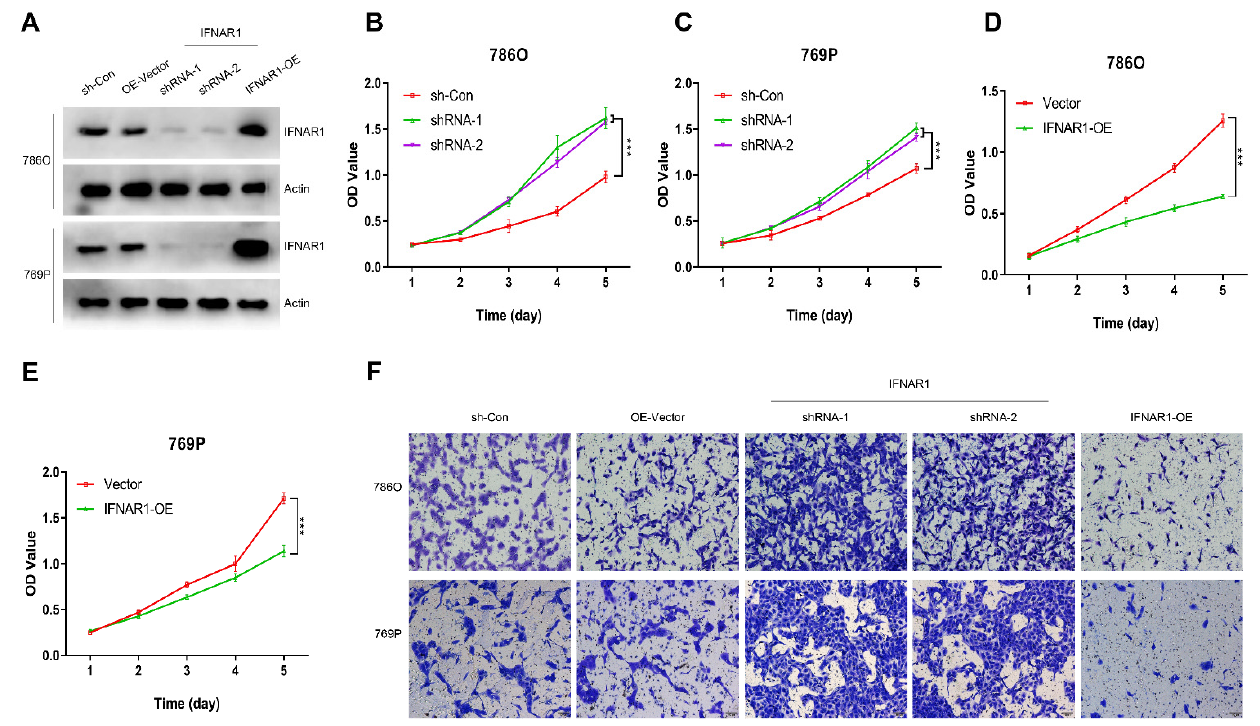
Figure 8. IFNAR1 inhibits the proliferation and migration capacities of ccRCC cells. ( A ) Western blotting assay of IFNAR1 expression in transfected 786O and 769P cell lines. ( B – E ) CCK-8 assays showed the effect of IFNAR1 knockdown ( B , C ) and overexpression ( D , E ) on the proliferation of 786O ( B , D ) and 769P ( C , E ) cells. (n = 6, error bars are mean ± SD, *** p < 0.001 using two-tailed Student’s t -test). ( F ) Representative images of the migration assays performed using 786O and 769P cells. Scale bars, 100 μ m.